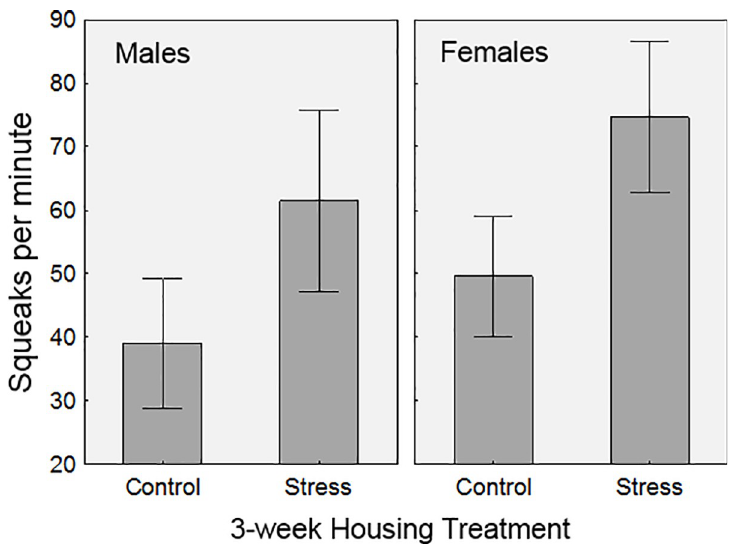
Fig 6. Average acoustic emission rates (during simulated attack) in relation to housing. Shown are frequencies of squeaks of male and female beetles that were housed for 3 weeks in two different conditions: normal housing (opaque container with ample wood for burying), and stressful housing (clear container, beetles prevented from burying). Whiskers represent 95% confidence